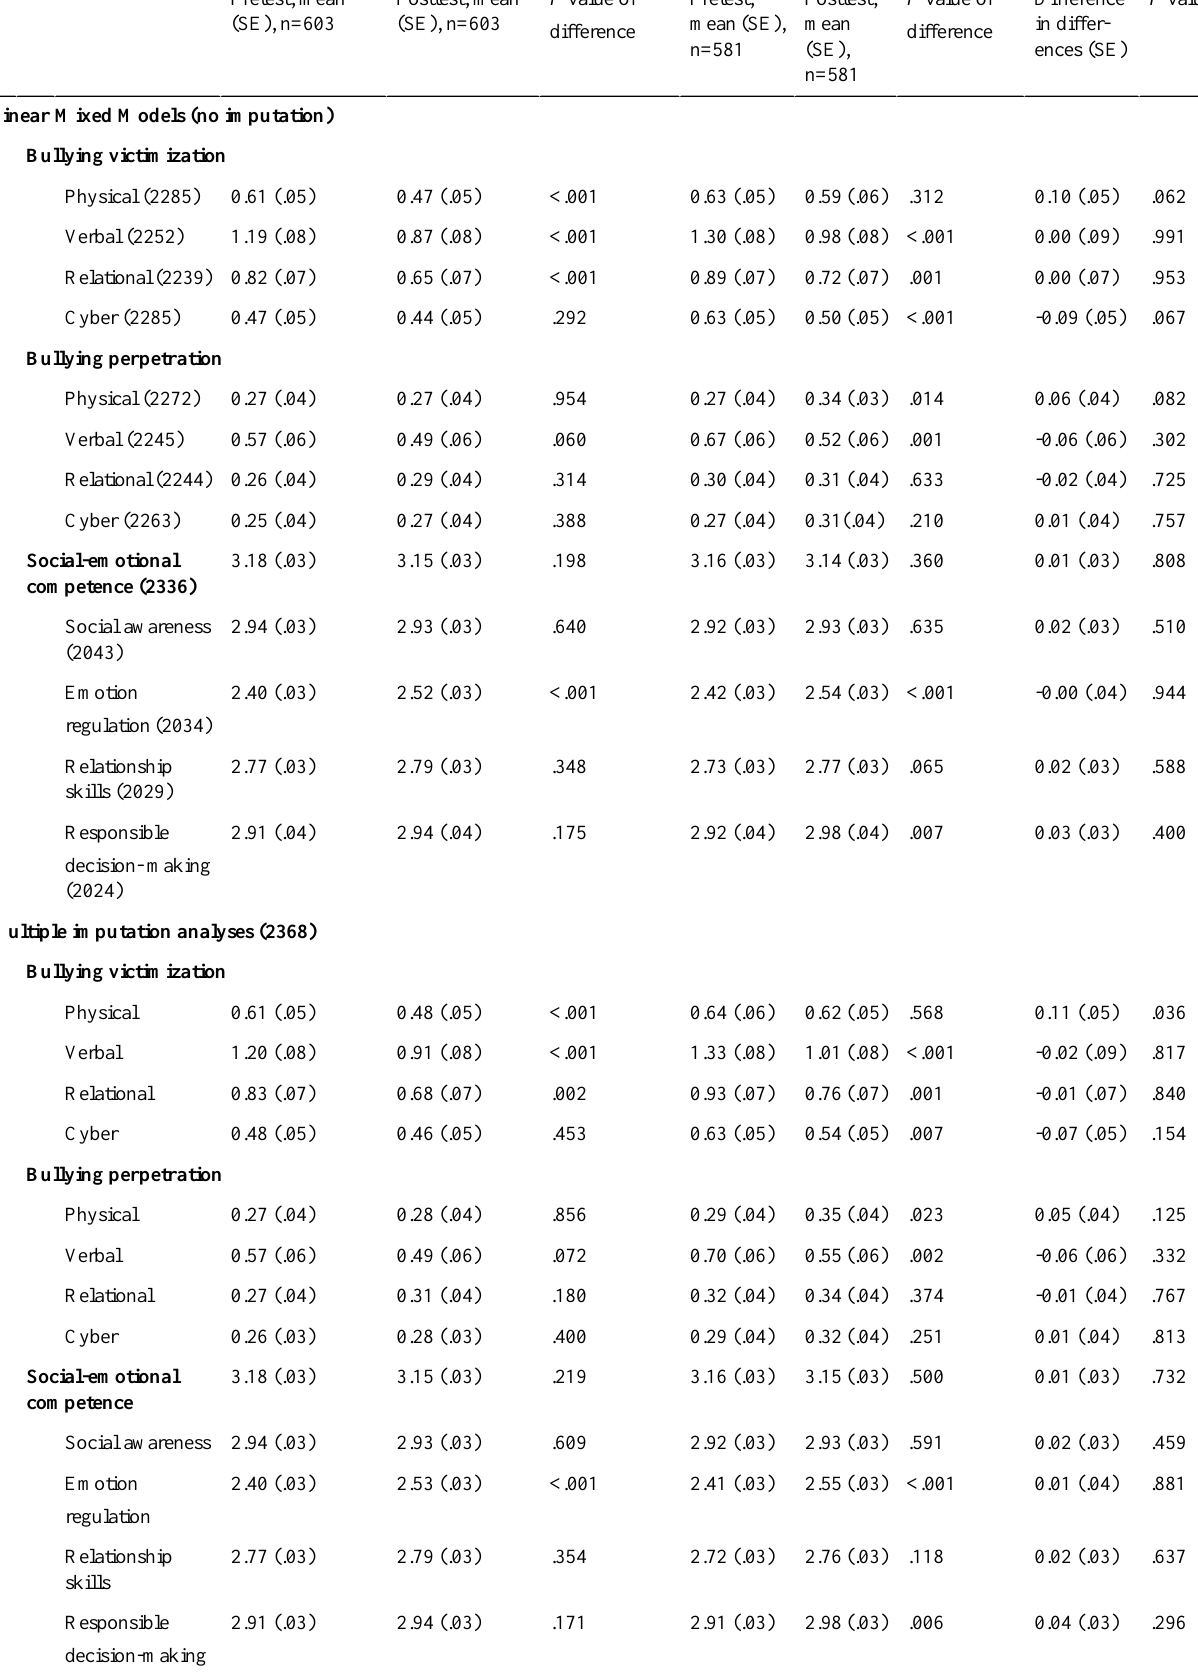
Table 3. Per-protocol study outcomes with standard errors. InteractionInterventionControlVariable (#